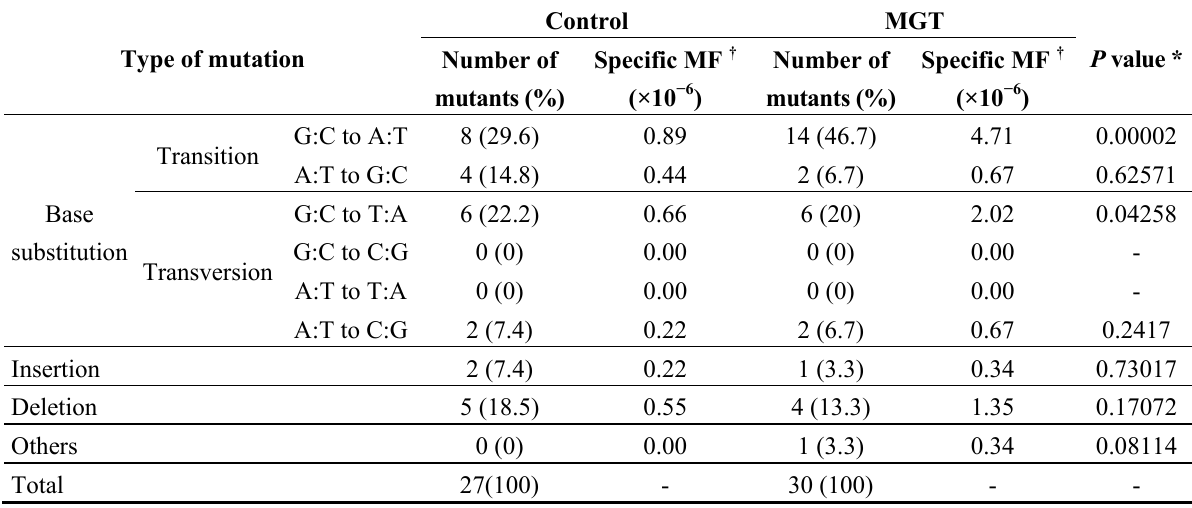
Table 2. Classification of gpt mutations isolated from the lungs of control and MGT-treated